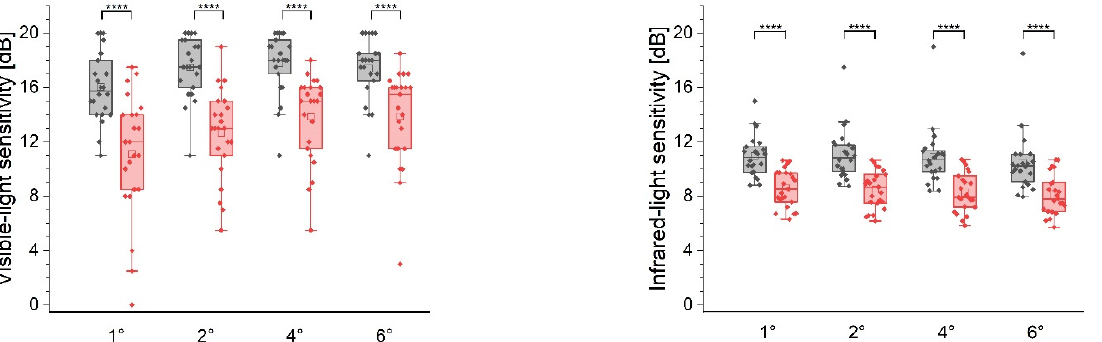
Figure 7. Box plots of the sensitivity results obtained along radially distributed retinal loci with a 1 ◦ , 2 ◦ , 4 ◦ , and 6 ◦ radius from the fovea. Note that the box width indicates the interquartile range. The whiskers denote the fifth and 95th percentiles; the outliers are marked as filled circles. The open squares refer to the mean value and solid lines indicate the median level. **** p < 0.001.